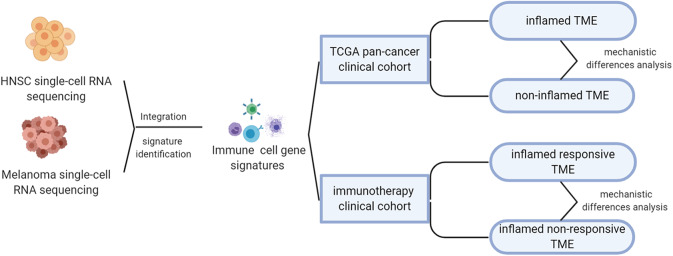
Overall design of this study.